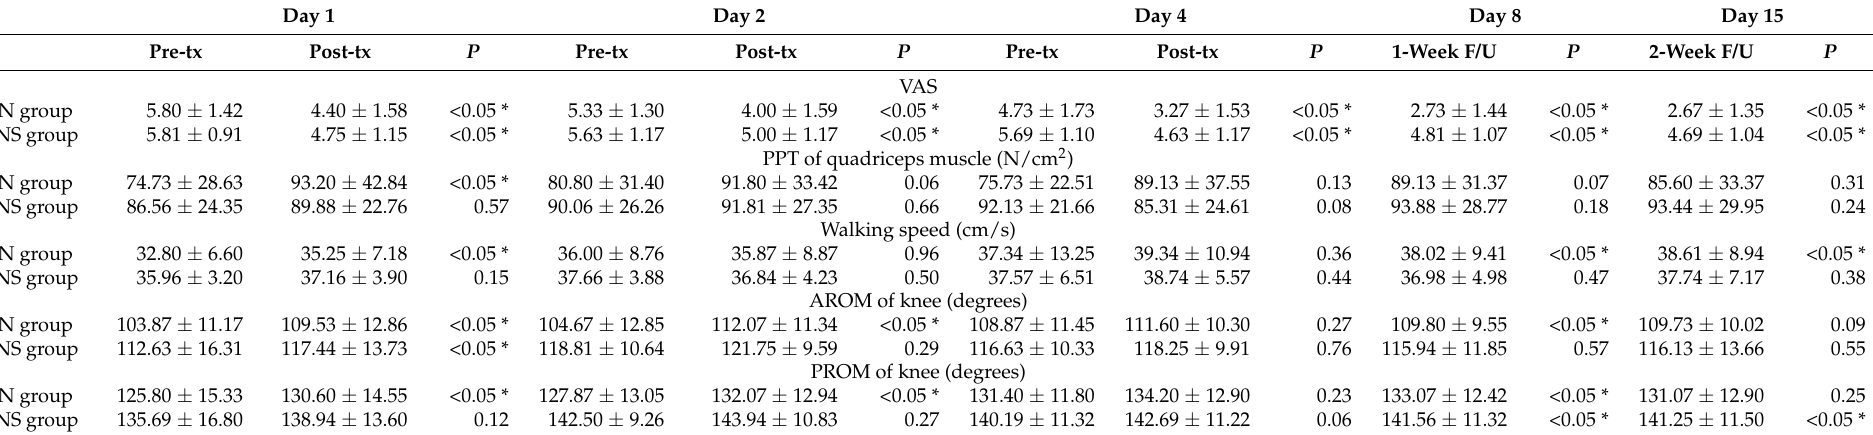
Table 2. Pain qualities (including VAS, PPT of quadriceps muscle, walking speed, and ROM of knee) compared between the FSN and TENS